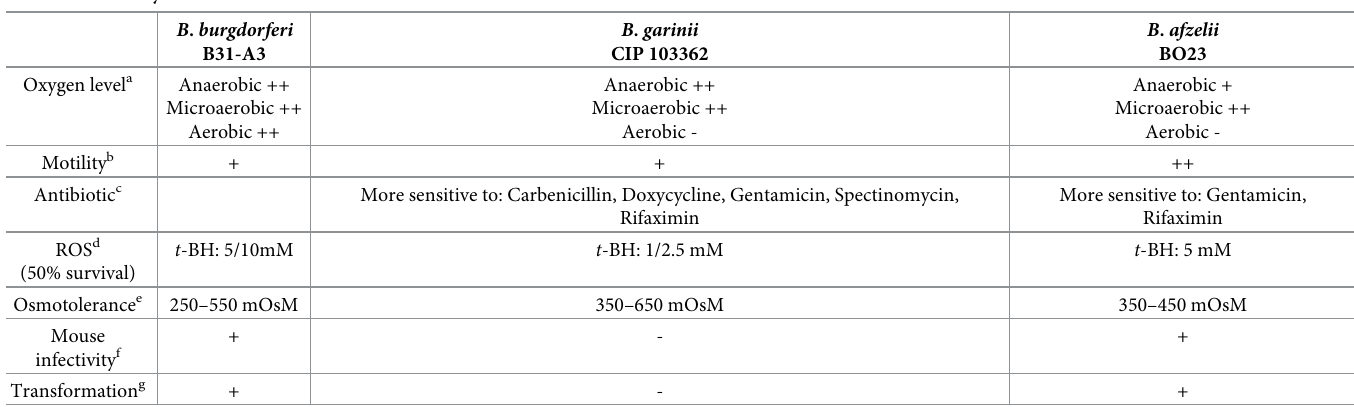
Table 4. Summary of the